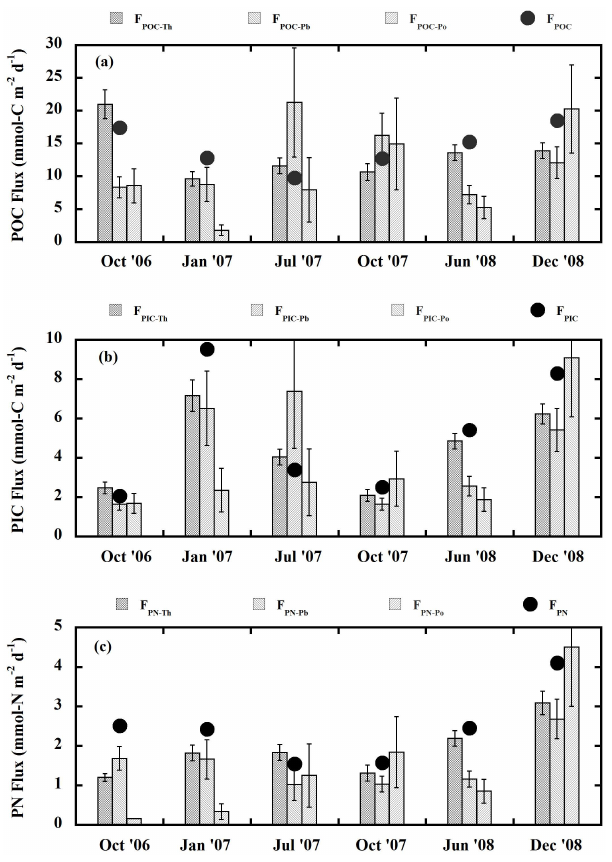
Fig. 8. Export fluxes of (a) POC, (b) PIC, and (c) PN estimated by 234 Th, 210 Pb, and 210 Po as proxy (bars) and measured by the floating traps (circles) from the euphotic layer. Error bars represent uncertainty based on propagated counting errors ( ± 1 σ